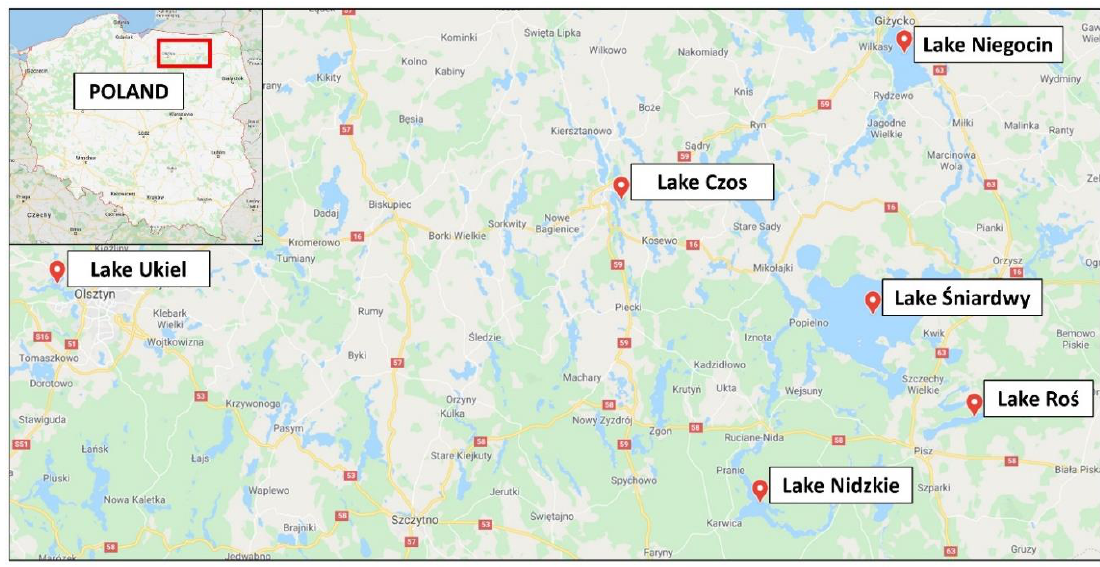
Figure 8. Location of the study area — lakes of Warmia and Mazury Region, Poland.